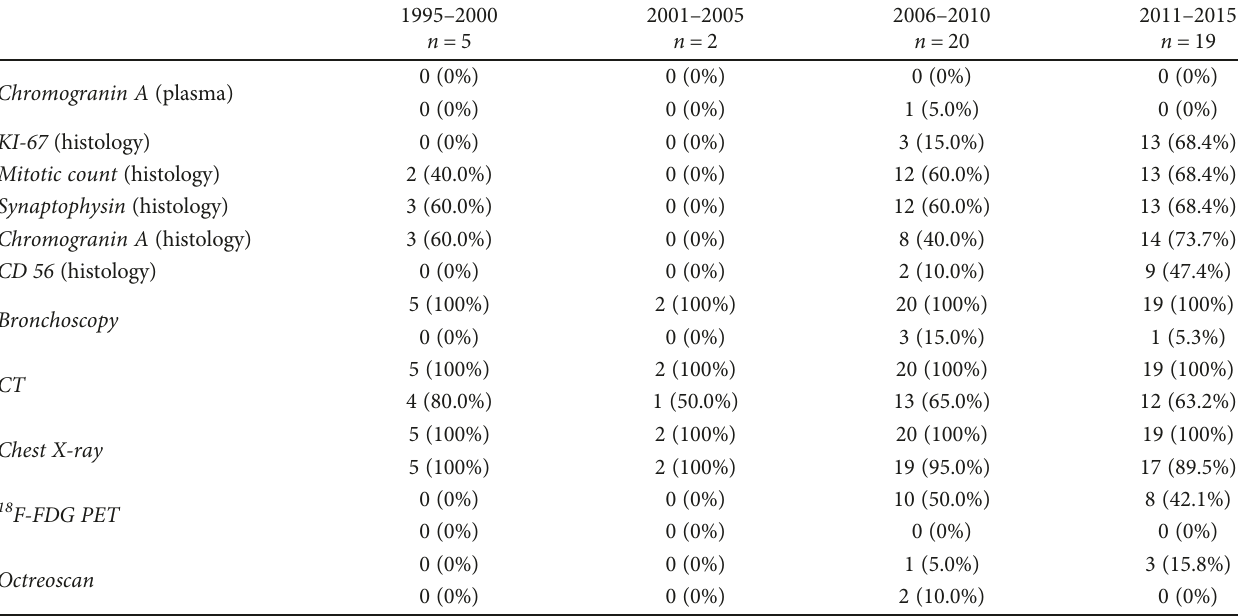
Table 5: Biochemistry, imaging, bronchoscopy, and pathology fi ndings in bronchial NET patients managed at our institution divided in chronological time frames.